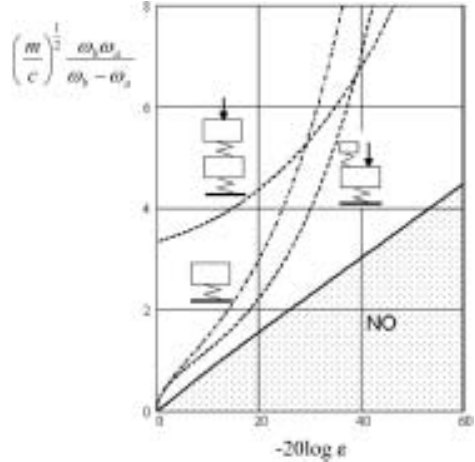
Fig. 2. Limiting performance of linear elastic-inertial vibration isolation